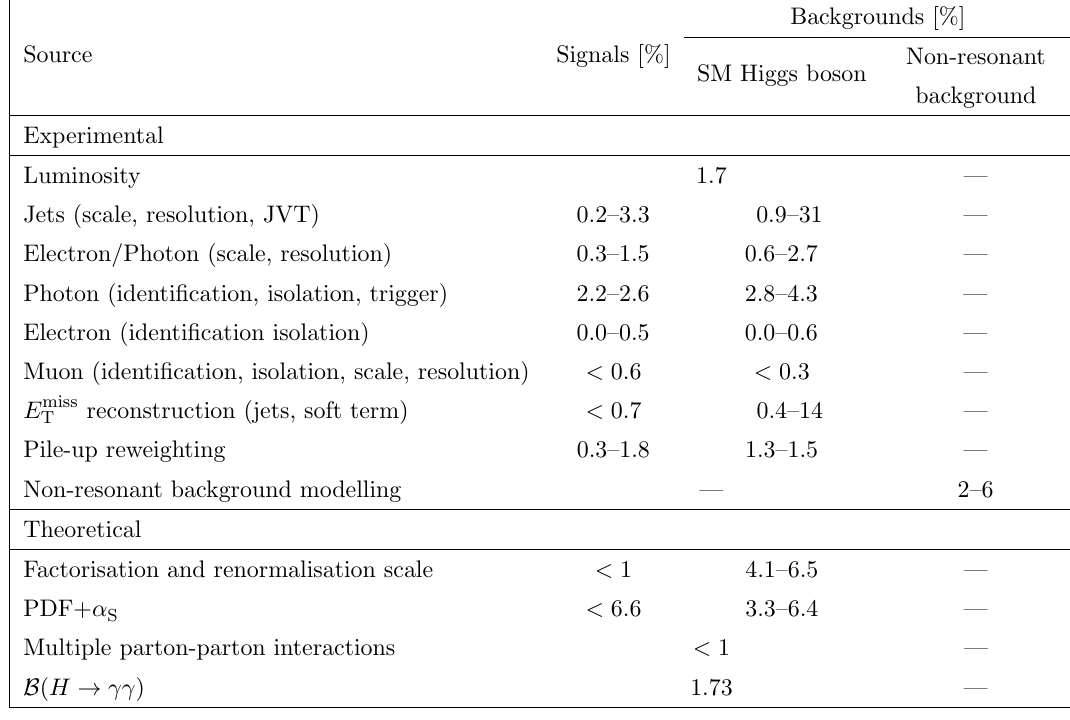
Table 3 . Breakdown of the dominant systematic uncertainties. The uncertainties (in %) in the yield of signals, the background from the SM Higgs boson processes and non-resonant background are shown. All production modes of the SM Higgs boson are considered together. A \|" indicates that the systematic uncertainty is not applicable to the corresponding sample. If a given source has a di(cid:11)erent impact on the various categories, the given range corresponds to the smallest and largest impacts among categories or among the di(cid:11)erent signal models used in the analysis. In addition, the potential bias coming from non-resonant background modelling is shown relative to the background in the signal region 120 < m (cid:13)(cid:13) < 130